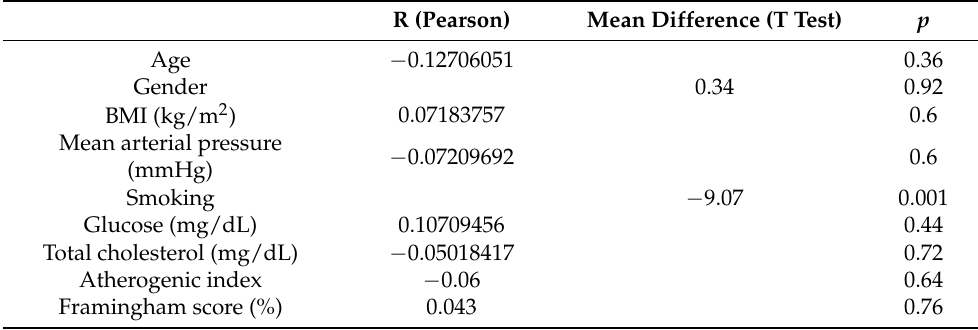
Table 4. Univariate analysis between demographic features and FMD% (Student’s t -test or correlation test).